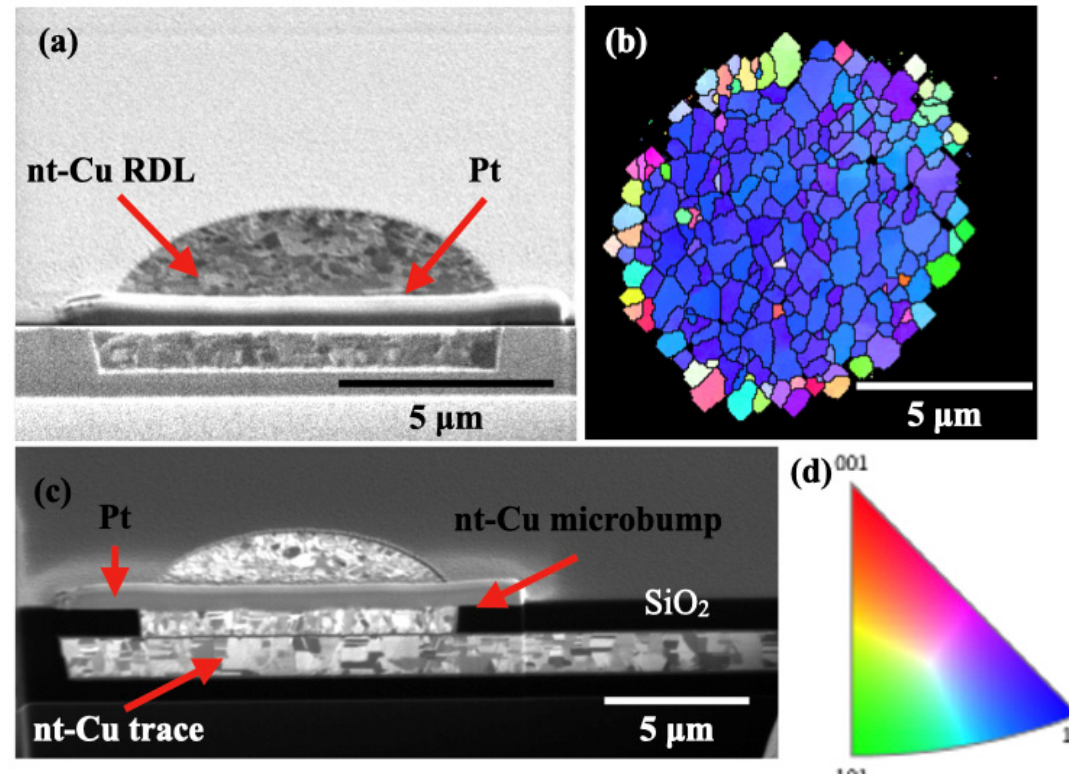
Figure 3. Microstructural characterization on the Cu via and joints before bonding. ( a ) Cross-sectional FIB image of unbonded nt-Cu RDL in the top die. ( b ) Plan-view EBSD analysis for a typical Cu bump on the test vehicle shows 78% of the via surface is (111)-preferred grains. ( c ) Cross-sectional FIB for the nt-Cu microbump on the nt-Cu trace in the bottom die. ( d ) Inverse pole figure of Cu.